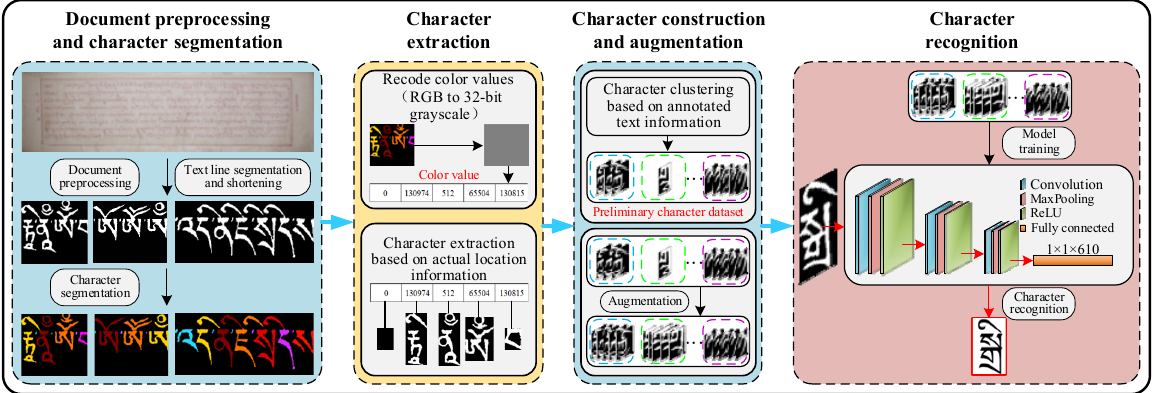
Figure 2. Construction framework of the character dataset of historical Tibetan documents.